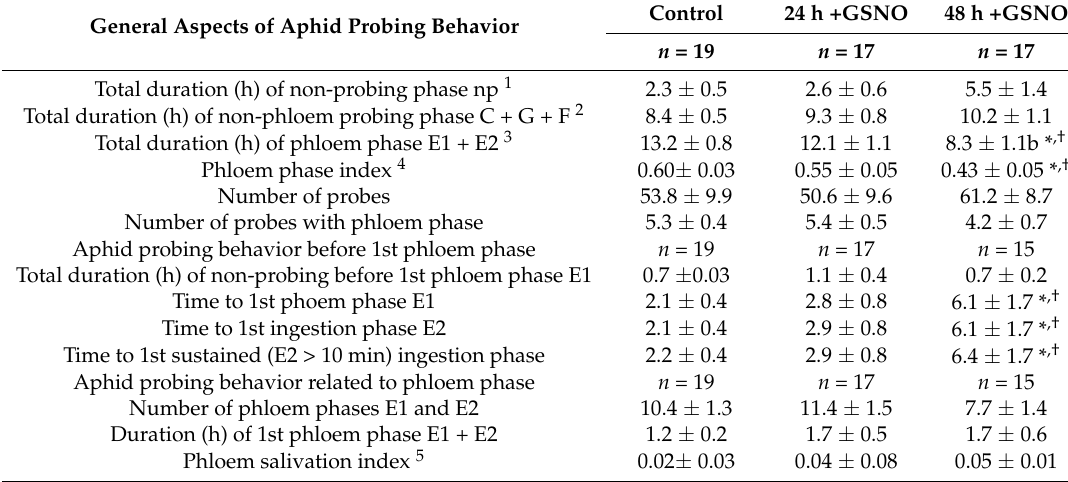
Table 3. Mean ( ± SE) non-sequential and sequential electrical penetration graph (EPG) parameters describing the probing behavior of A. pisum on P. sativum L. treated with